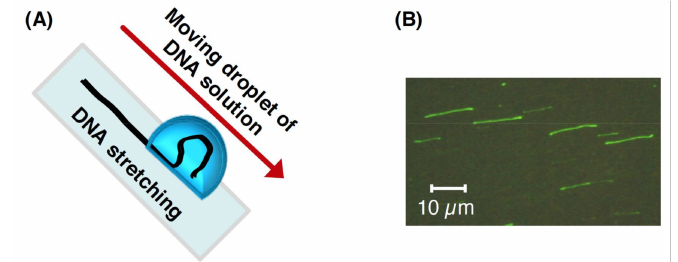
Figure 7. Stretching single DNA molecules using the molecular combing method. ( A ) Conceptual diagram of the stretching manipulation of single DNA molecules by using the moving droplet method. ( B ) Image of the stretched single DNA molecules. Refer to [81] for